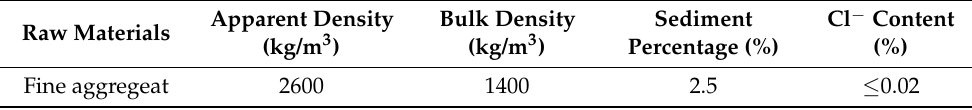
Table 2. Physical parameters of fine